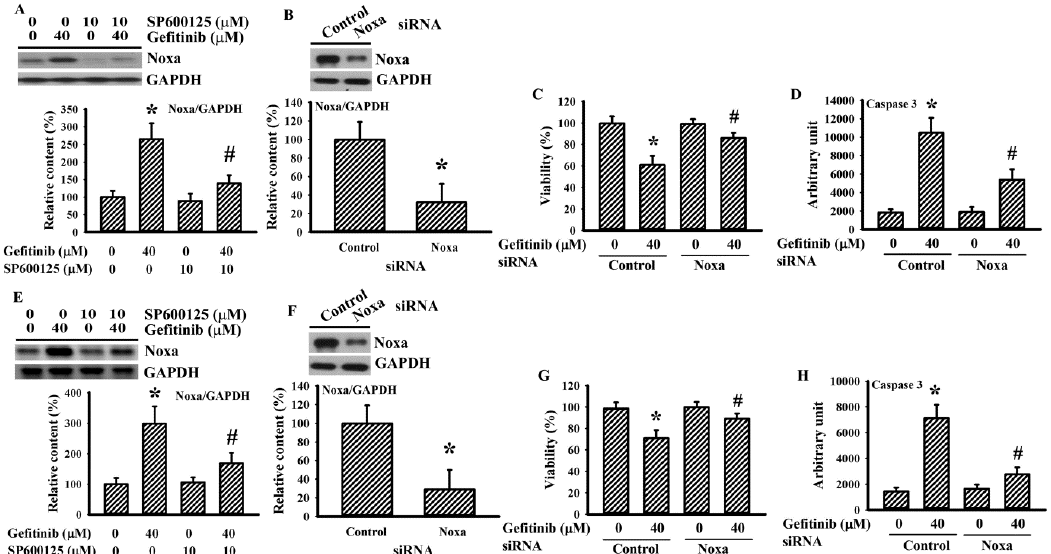
Figure 6. Noxa is crucial to gefitinib-induced apoptosis in glioma cells. H4 ( A ) and U87 ( E ) cells were treated with gefitinib (0 and 40 μM) together, with or without SP600125 (10 μM). Protein extracts (6 h) were subjected to Western blot with indicated antibodies. Representative blots of three independent experiments and quantitative data are shown. H4 ( B – D ) and U87 ( F – H ) cells were transfected with control siRNA (1 nM) or Noxa siRNA (1 nM) for 24 h. Protein extracts were subjected to Western blot with indicated antibodies. Representative blots of three independent experiments and quantitative data are shown ( B , F ). The transfected cells were then treated with gefitinib (0 and 40 μM). Cell viability (24 h) was measured with the alamarBlue assay ( C , G ). Caspase 3 activity (6 h) was measured with enzymatic assay ( D , H ). Protein contents were normalized with GAPDH. * p < 0.05 vs. untreated control and # p < 0.05 vs. gefitinib (40 μM), n = 4 ( C , D , G , H ).